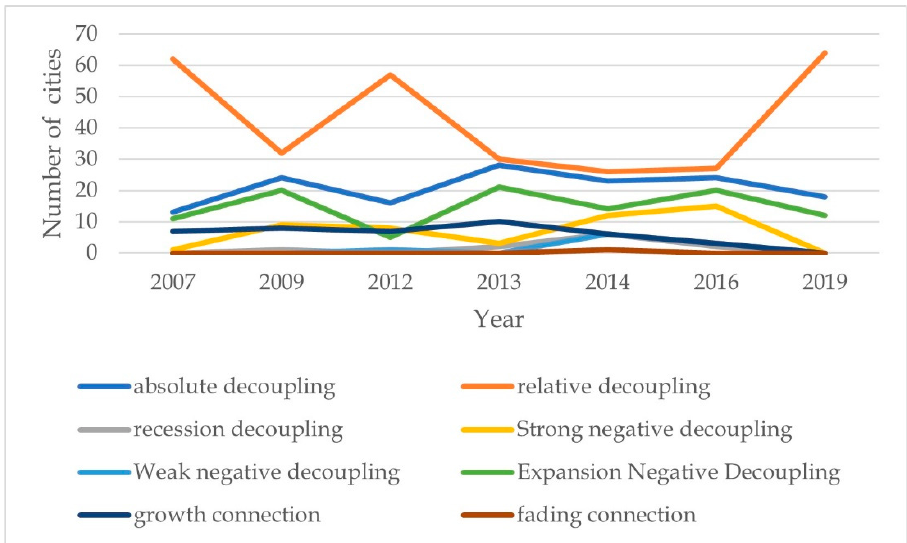
Figure 5. Number of cities decoupling states.